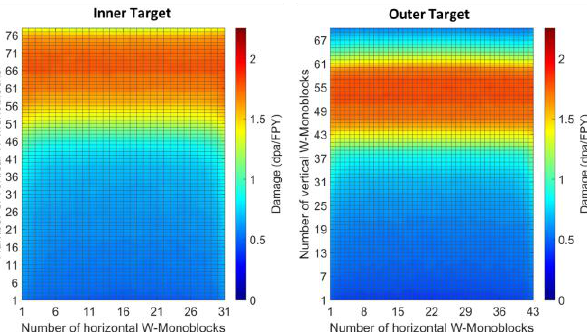
Figure 18. Nuclear damage (dpa/FPY) distribution on W-monoblocks of the inner ( left ) and outer ( right ) target, with HCPB blanket.